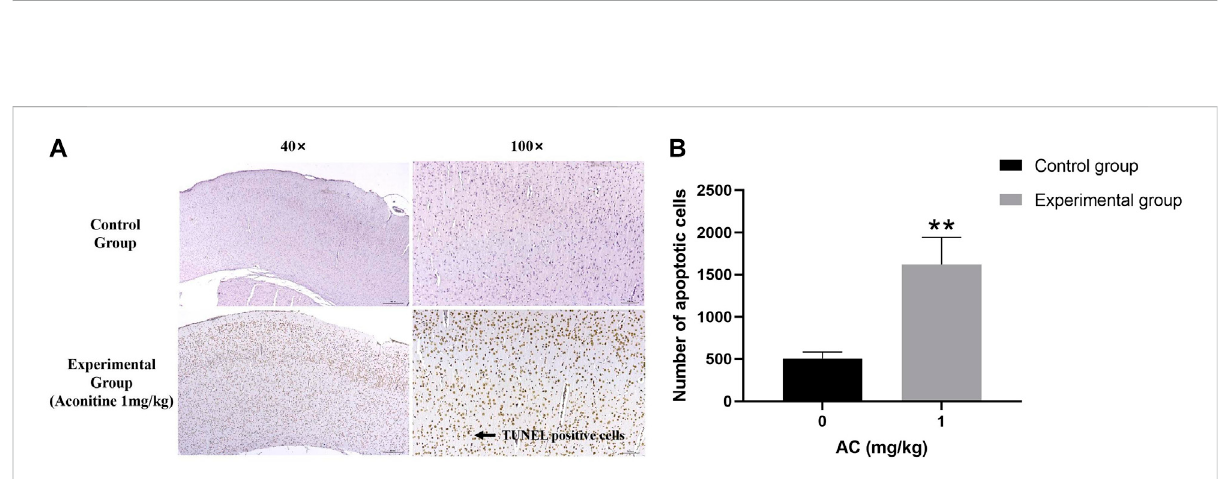
FIGURE 10 Treatment of aconitine for 7 days increased apoptosis of hippocampus neurons. (A) Representative images magni fi ed 40 and 100 times in hippocampus. (B) Quantitatively analyzed thenumber ofapoptotic cellsincontroland experimentalgroup (×100).(** p < 0.01 versuscontrolgroup.)